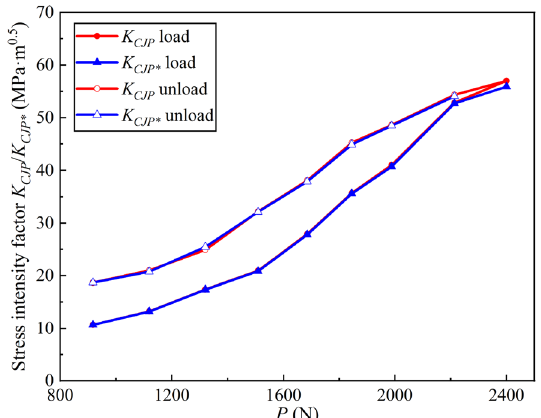
Figure 13 Variation trend of plastic flow factor ρ with load